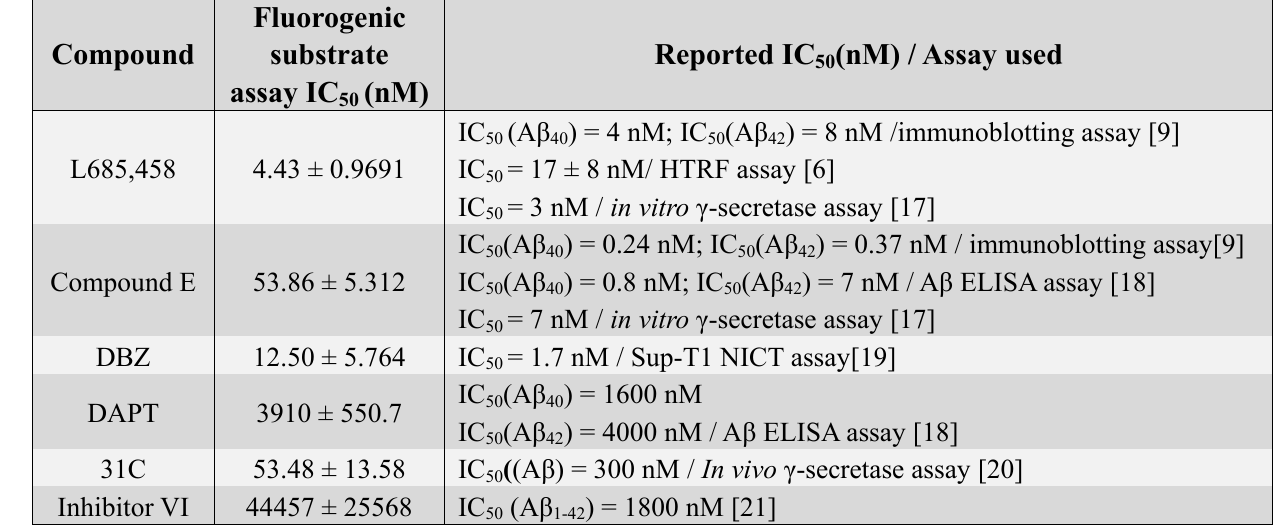
Table 1. Comparison of IC values of various compounds obtained by fluorogenic 50 substrate assay and previous reported